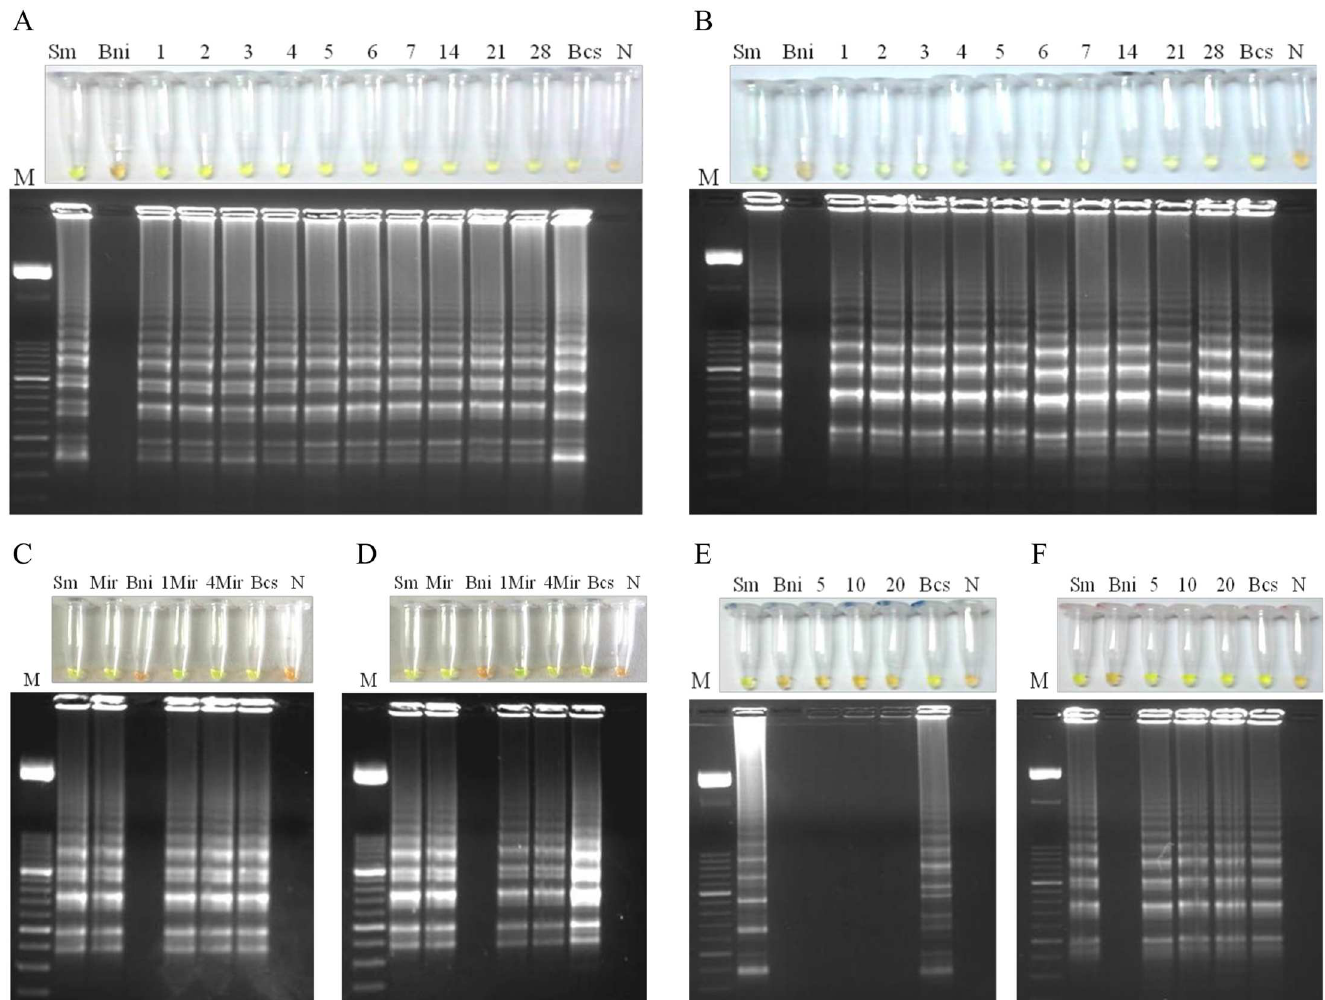
Fig 5. Application of LAMP in snails samples: Biompha -LAMP analysis. (A) and (B) Analysis of snails before cercarial sheddingat different days post-exposure to 9 miracidiaeach using a commercial kit or the heat NaOH extraction method for DNA obtaining,respectively. Lanes M, 50 bp DNA ladder (Molecular weight marker XIII, Roche); lane Sm, Schistosoma mansoni DNA (1 ng); lanes Bni, Biomphalaria glabrata DNA non infected; Lanes 1–7, 14, 21 and 28, days post-exposure to miracidia; lanes Bcs, Biomphalaria glabrata DNA with cercarial shedding; lanes N: negative control (no DNA template). (C) and (D) Analysis of snails exposedto one or four miracidiaat 24h post-exposure using a commercialkit or the heat NaOH extraction method, respectively. LanesM, 50 bp DNA ladder(Molecularweight marker XIII, Roche); lanes Sm, Schistosomamansoni DNA (1 ng); lanes Mir; DNA obtainedfrom one miracidium; lanes Bni, Biomphalaria glabrata DNA non infected; lanes 1Mir and 4Mir, DNA obtainedfrom snails exposedto one or 4 miracidia, respectively; lanes Bcs, Biomphalaria glabrata DNA with cercarial shedding;lanes N: negativecontrol (no DNA template). (E) and (F) Analysis of pooled samplescontainingsnails previouslyexposedto 1 miracidiumor with confirmedcercarial shedding,respectively, using the heat NaOH extraction method. LanesM, 50 bp DNA ladder(Molecularweight marker XIII, Roche); lanes Sm, Schistosomamansoni DNA (1 ng); lanes Bni, Biomphalaria glabrata DNA non infected; lanes 5, 10 and 20, DNA obtained from pooledsamples containing one snail exposedto 1 miracidium or with confirmedcercarial shedding togetherwith 5, 10 or 20 uninfectedsnails; lanes Bcs, Biomphalaria glabrata DNA with cercarial shedding;lanes N: negativecontrol (no DNA template).